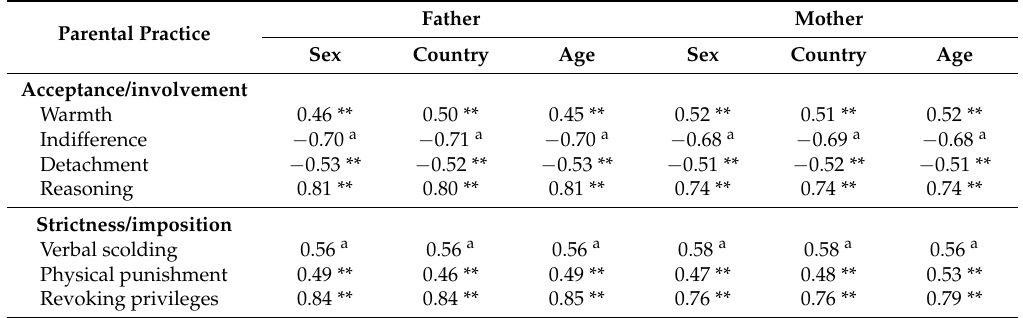
Table 4. Confirmatory factor analysis (CFA) standardized factor loadings of fathers’ and mothers’ parenting practices of the most constrained model.